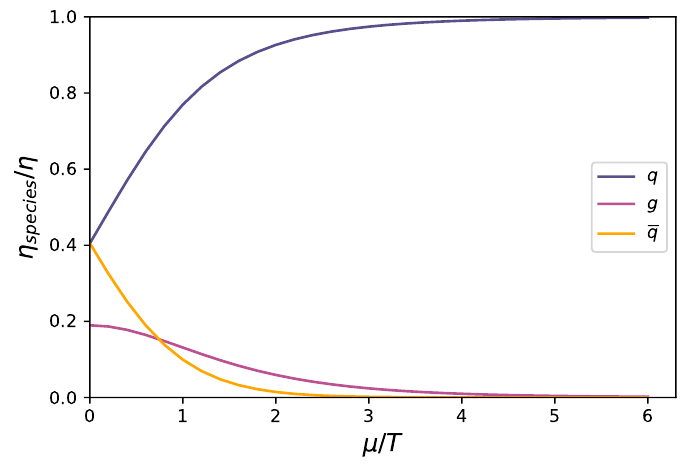
Figure 5 . Contribution from each species to shear viscosity, normalized by the sum of all contri- butions, as a function of chemical potential.